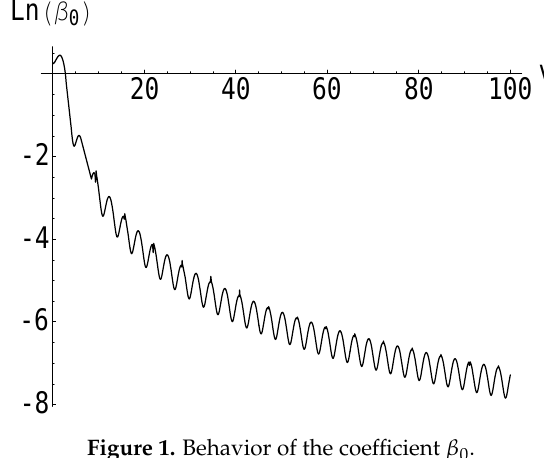
Figure 1. Behavior of the coefficient β 0 .